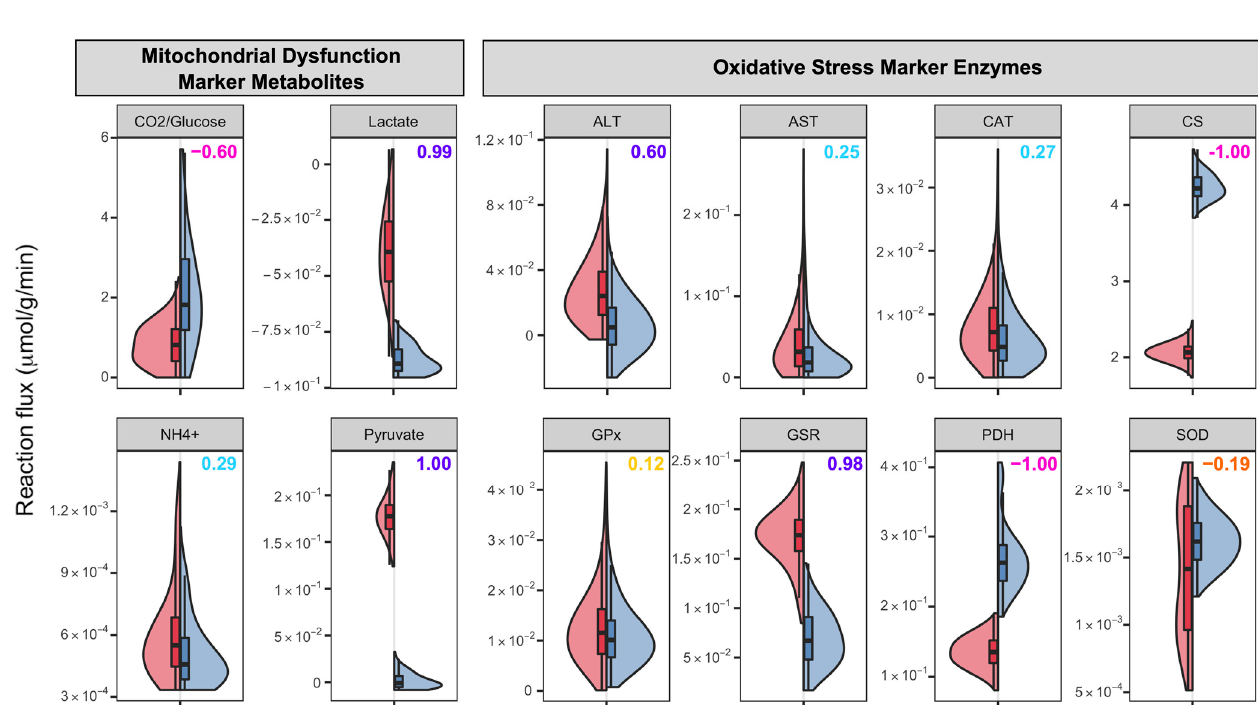
Figure 4. Reaction fluxes for several mitochondrial dysfunction and oxidative stress markers in µmol/(g min) acquired through the uniform sampling of ASD-specific and control models. For the metabolites and enzymes, the reaction fluxes indicate the secretion rate of the metabolite or the sum of the reaction fluxes catalyzed by the enzyme in all compartments, respectively. The numbers of the upper right corner of each graph denote the Cliff’s d values. The color codes for Cliff’s d values